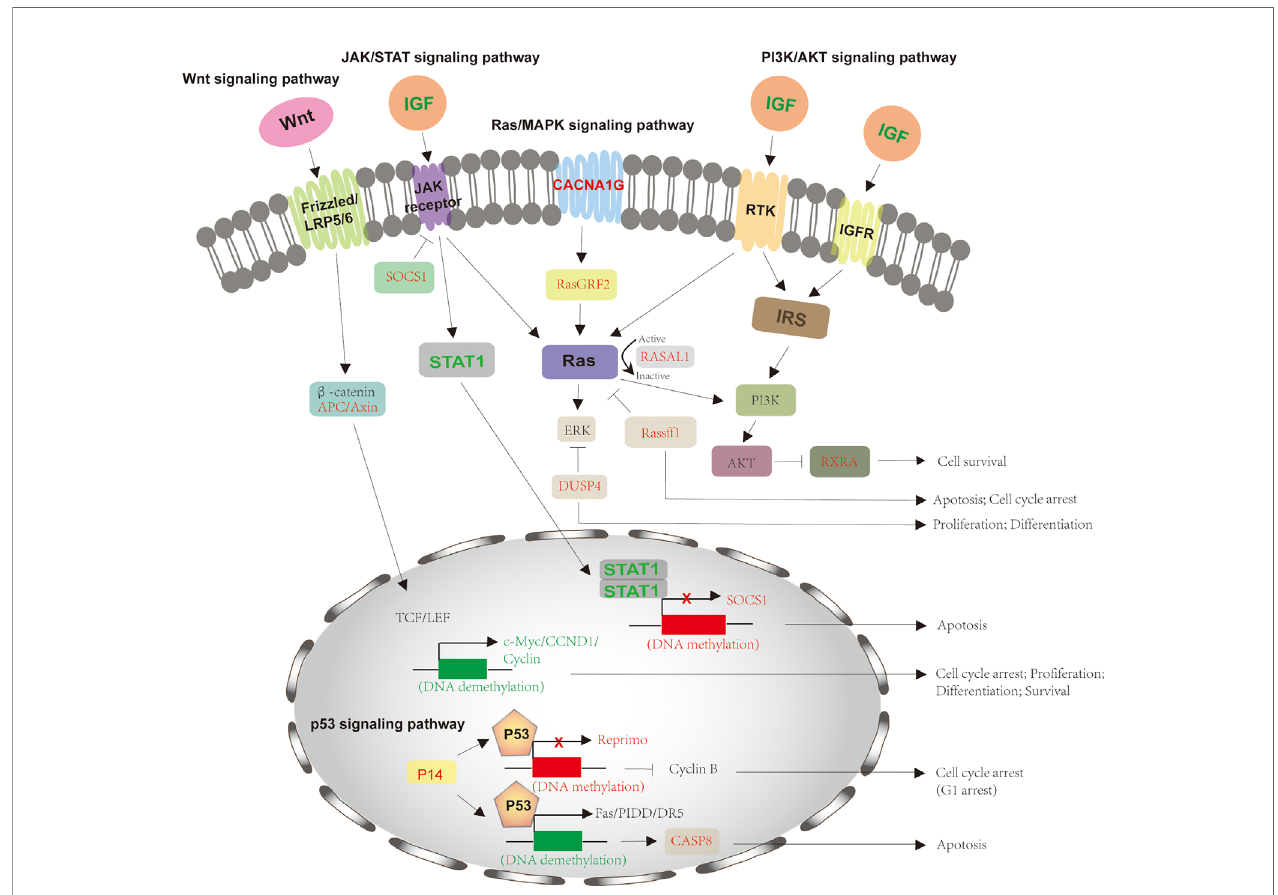
FIGURE 2 | Signaling pathways involved in HCV-induced HCC. The process of HCV-induced HCC involves in several signaling pathways, including Wnt signaling pathway, Ras/MAPK signaling pathway, p53 signaling pathway, JAK-STAT pathway, and PI3K-AKT pathway. For Wnt signaling pathway, HCV infection downregulates APC and Axin2 expression via hypermethylation, which activates LEF/TCF-dependent downstream genes, such as c-Myc, CCND1, and Cyclin and thus promotes cell proliferation and differentiation. The HCV-mediated activation of JAK-STAT pathway by decreasing SOCS1 and increasing IGF, STAT1 to forms a negative feedback and inhibits cell apoptosis. The downregulation of DUSP4, RASAL1, and RasGRF2 by HCV infection also stimulates Ras/ MAPK signaling pathway for cell growth. IGF also activates PI3K-AKT pathway by reducing RXRA expression. p53 signaling pathway is also modulated by HCV infection through downregulation of P14, Reprimo and CASP8, preventing from cell cycle arrest and apoptosis. The crosstalk between different signaling pathways happens and cooperates for cell growth and tumorigenesis. The proteins with normal expression are black; the downregulated proteins, resulted from these gene promoters ’ DNA methylation, are red and upregulated proteins for gene promoters ’ DNA demethylation are green. APC, adenomatous polyposis coli; DUSP1, dual ‐ speci fi city phosphatase 1; JAK/STAT, Janus kinase-signal transducer and activator of transcription; IGF, insulin-like growth factor; CCND1, cyclin D1; SOCS1, suppressor of cytokine signaling 1; RASAL1, Ras protein activator like 1; RasGRF2, Ras protein-speci fi c guanine nucleotide-releasing factor 2; CASP8, caspase 8; MAPK, mitogen-activated protein